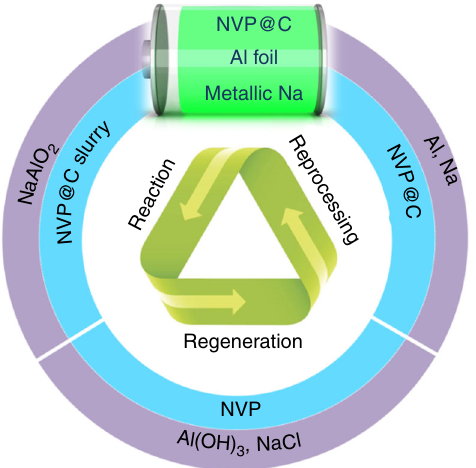
Fig. 3 Schematic closed-loop utilization of a proposed NIB unit: Loop 1 (blue), reformation of NVP@C from the recycled NVP; Loop 2